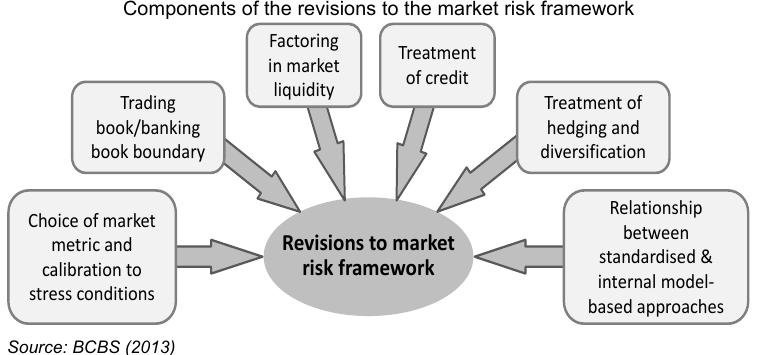
Components of the revisions to the market risk